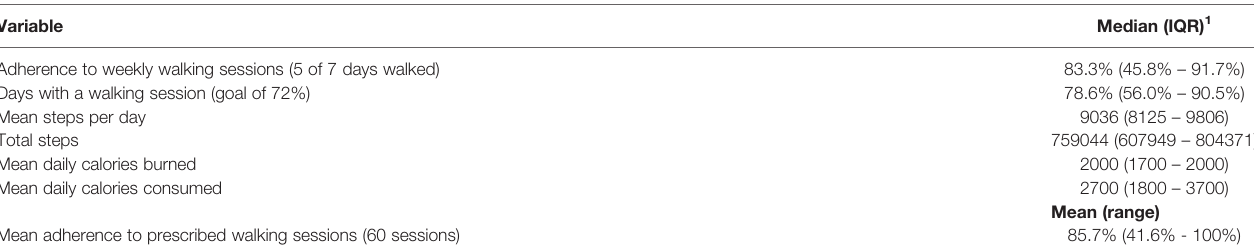
TABLE 2 | Activity and Nutrition Adherence.